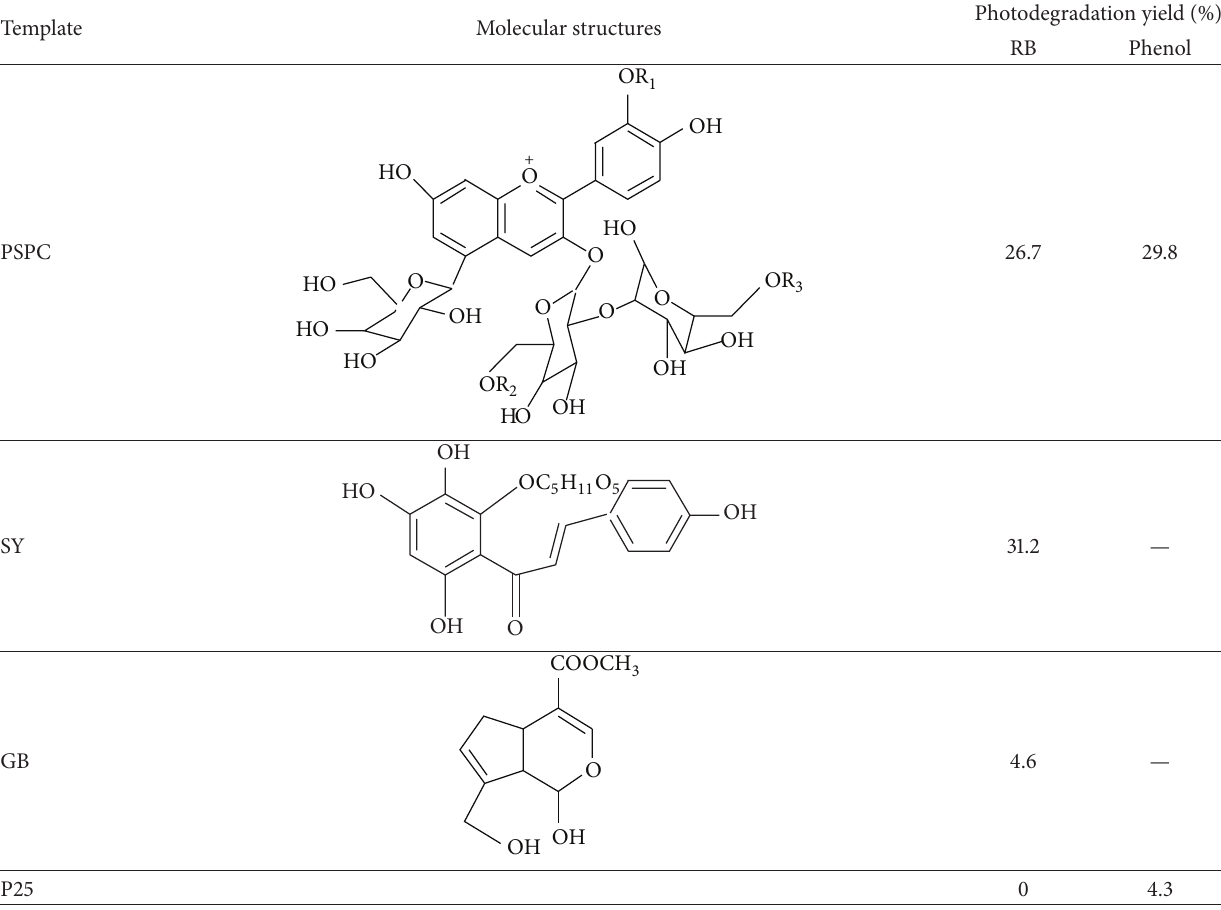
Table 1: Summary of photodegradation yields for degradation of RB and phenol under visible-light irradiation over MTiO synthesized by using different natural pigments as template.